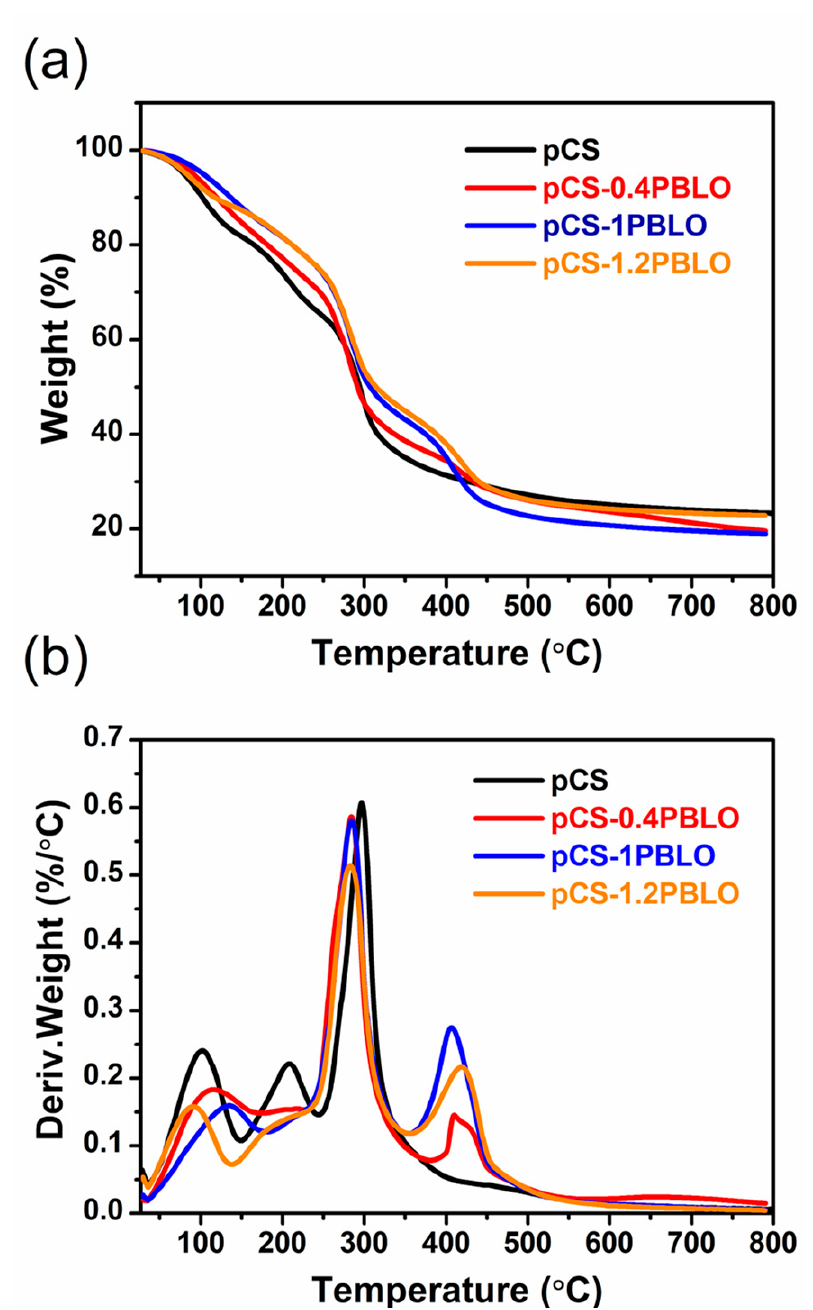
Figure 3. ( a ) TGA and ( b ) DTG profiles of pCS, pCS ‐ 0.4PBLO, pCS ‐ 1PBLO, and pCS ‐ 1.2PBLO.